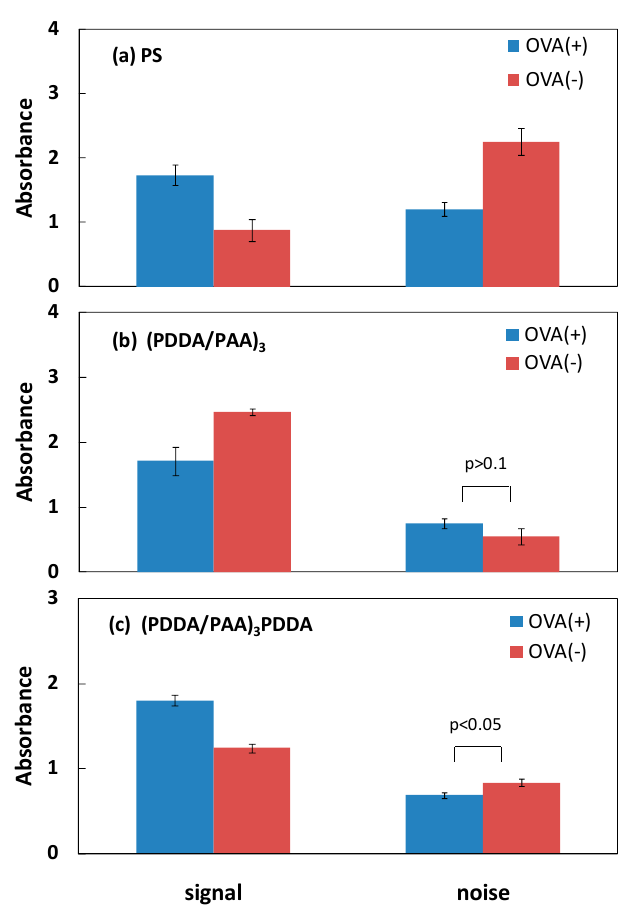
Figure 3. Specific signal and noise associated with antigen detection, with and without OVA blocking reagent adsorption, on the PS plate ( a ); (PDDA/PAA) 3 ( b ); and (PDDA/PAA) 3 PDDA ( c ) ( n = 3).